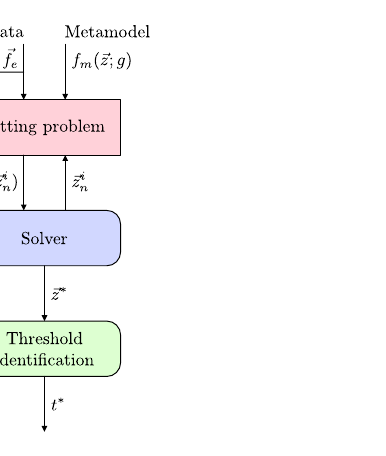
Figure 1. Proposed method based on the Generalized Gaussian function as the metamodel and the Cuckoo Search Algorithm as the